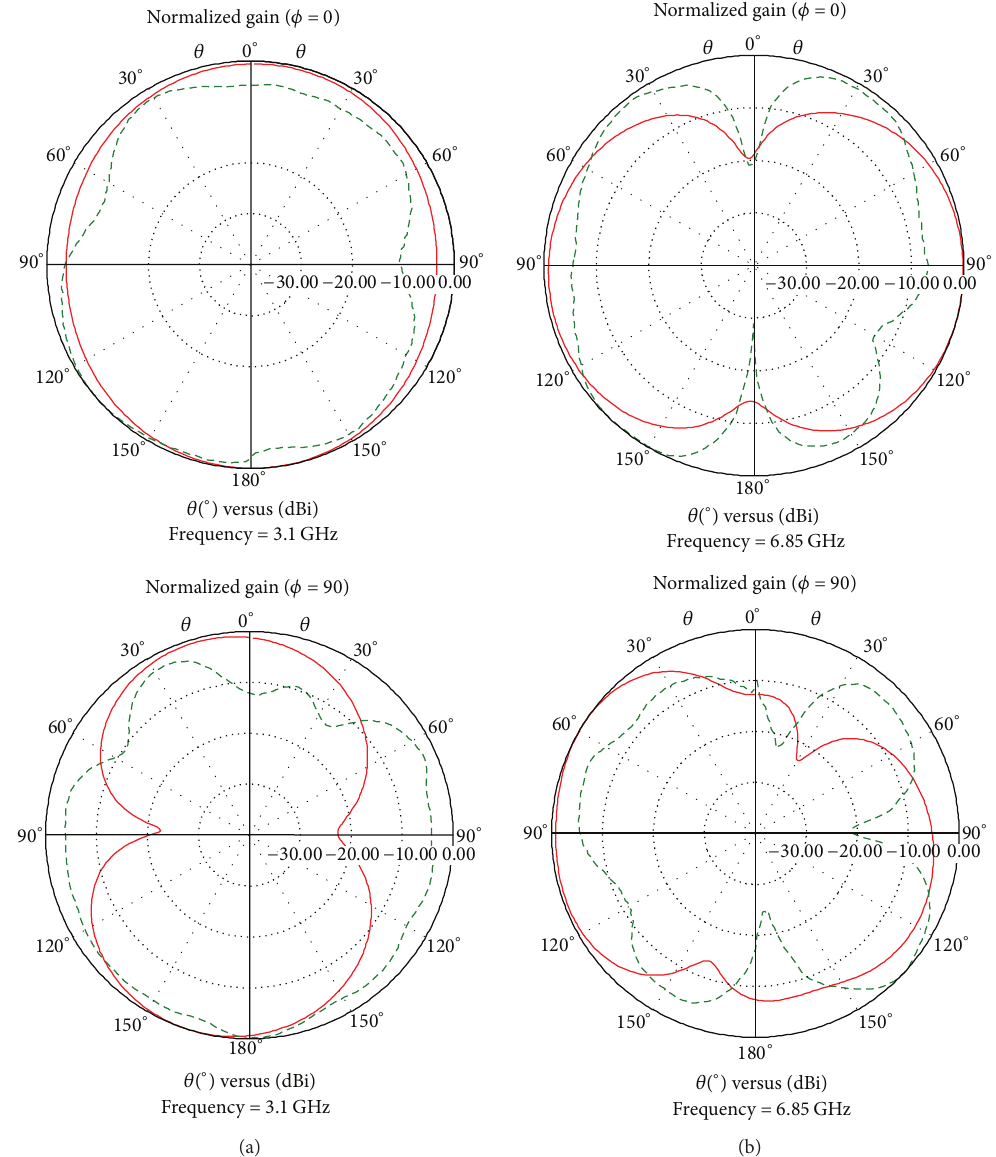
Figure 7: Simulated (solid) and measured (dashed) E-plane and H-plane radiation patterns for the center frequency: (a) 3.1GHz and (b) 6.85 GHz for ON state of the